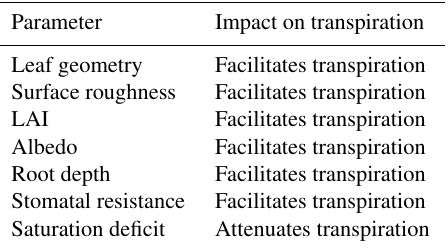
Table 1. The impact of the different influencing factors on transpi- ration of forests in comparison to